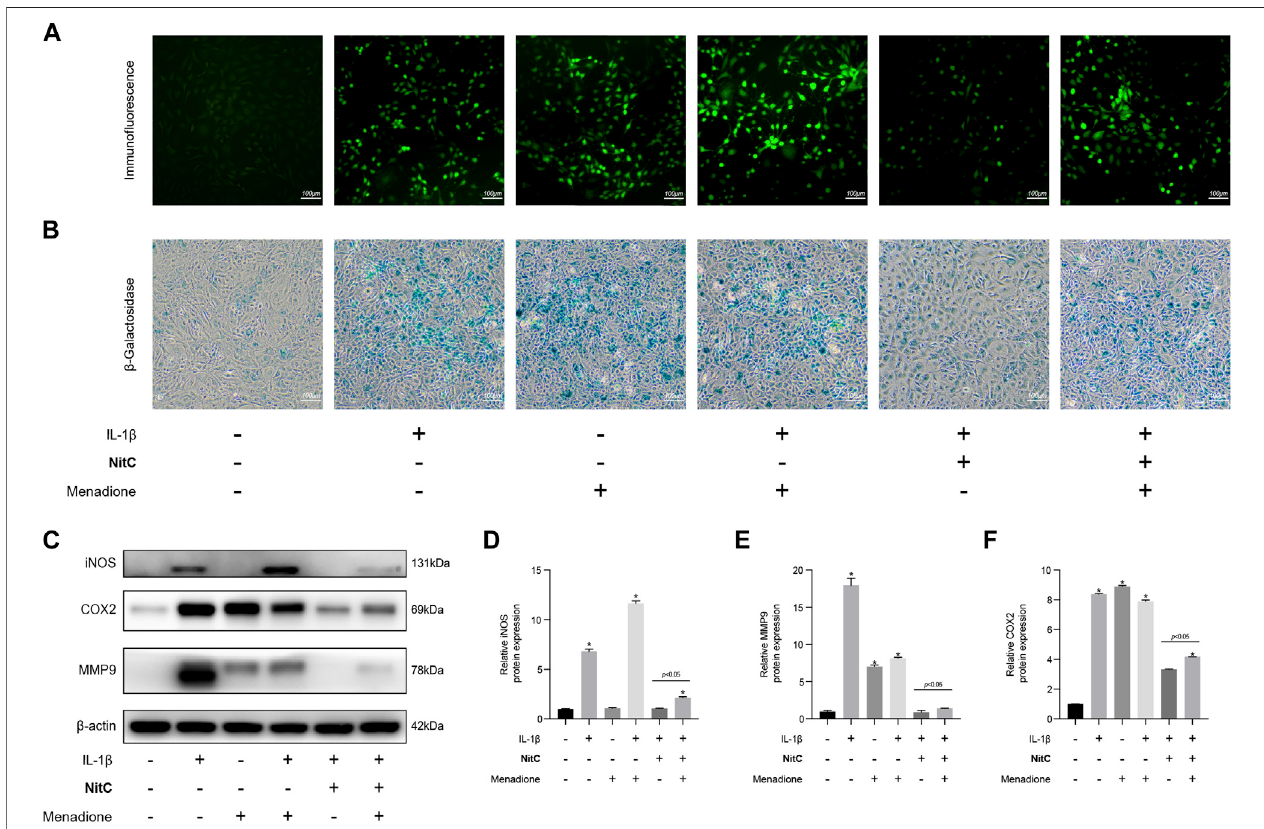
FIGURE 5 | Regeneration of ROS rescue the impact of NitC on RACs. (A) The ROS levels in RACs were detected through immuno fl uorescence analysis. (B) β - Galactosidase activity assay was performed to identify the senescent RACs. (C) WB analysis of iNOS, COX2, MMP9, and β -Actin. The relative protein expression was quanti fi ed and shown respectively in (D – F) . p p < 0.05 versus the model group, other signi fi cant differences between the groups were shown as indicated in the fi